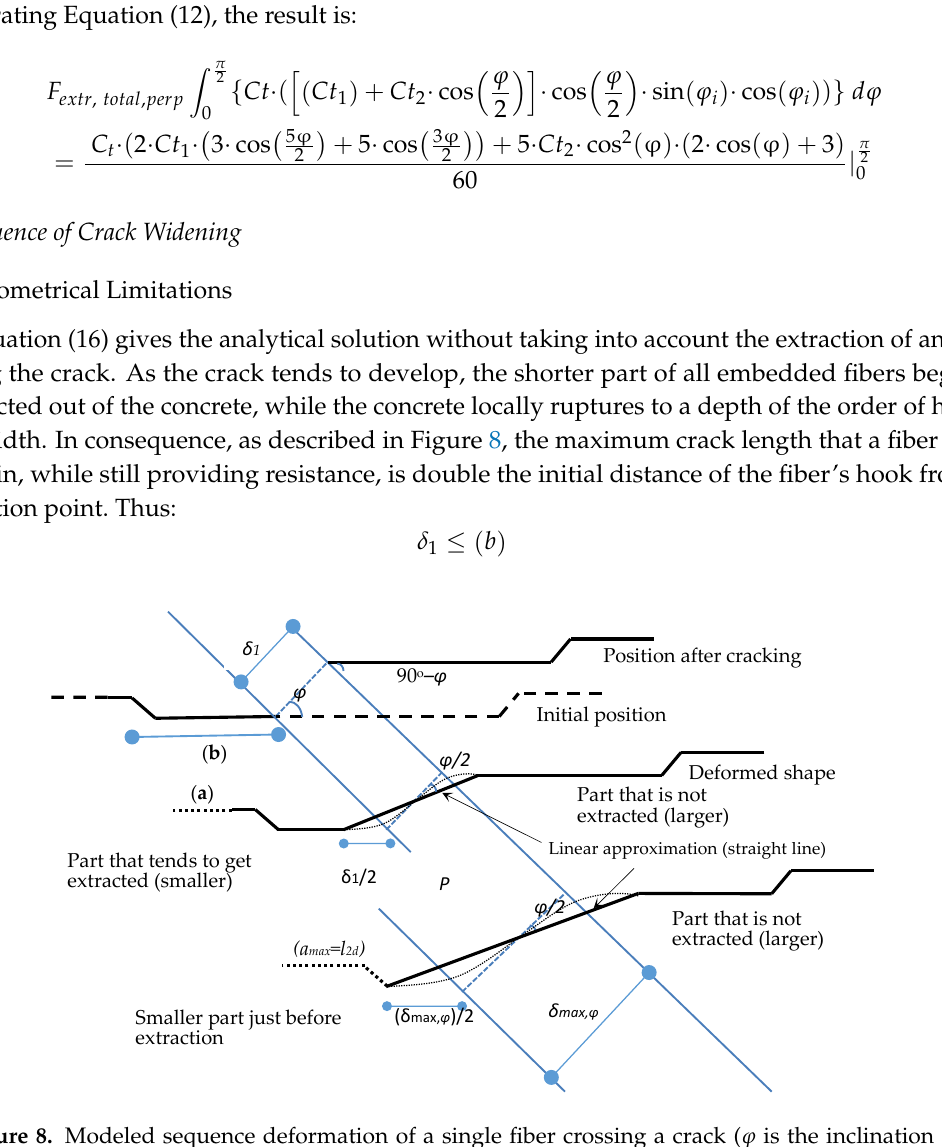
Figure 8. Modeled sequence deformation of a single fiber crossing a crack ( ϕ is the inclination of the fiber from the perpendicular to the crack direction, and δ (δ ≤ δ max,ϕ ) is the width of the crack. ( a ): gradual shortening of the smaller part of the fiber due to extraction; ( b ): available extraction length at the formulation of the crack; ( δ max, ϕ ): maximum crack length that can be sustained by a fiber forming angle ϕ with a crack, with available distance to hook end equal to b